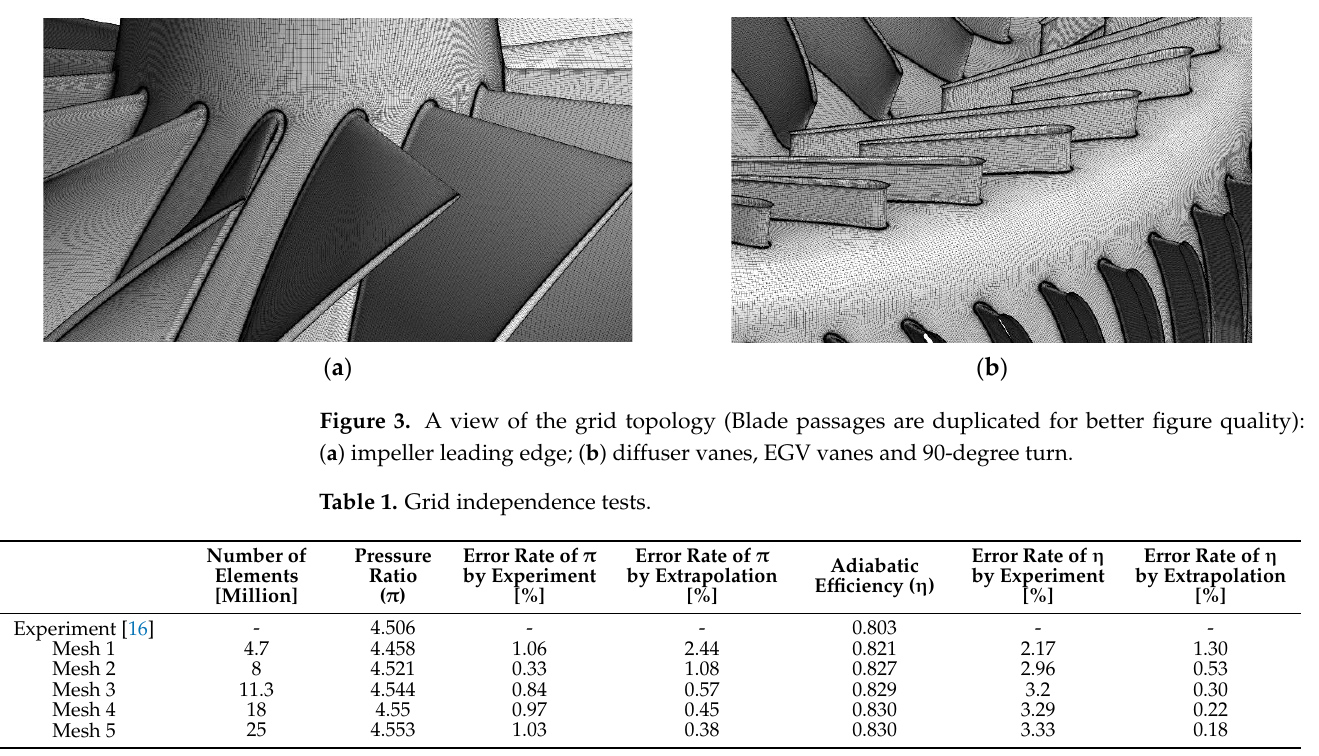
Figure 2. Grid independence and extrapolation results: ( a ) pressure ratio, π; ( b ) adiabatic efficiency, η.